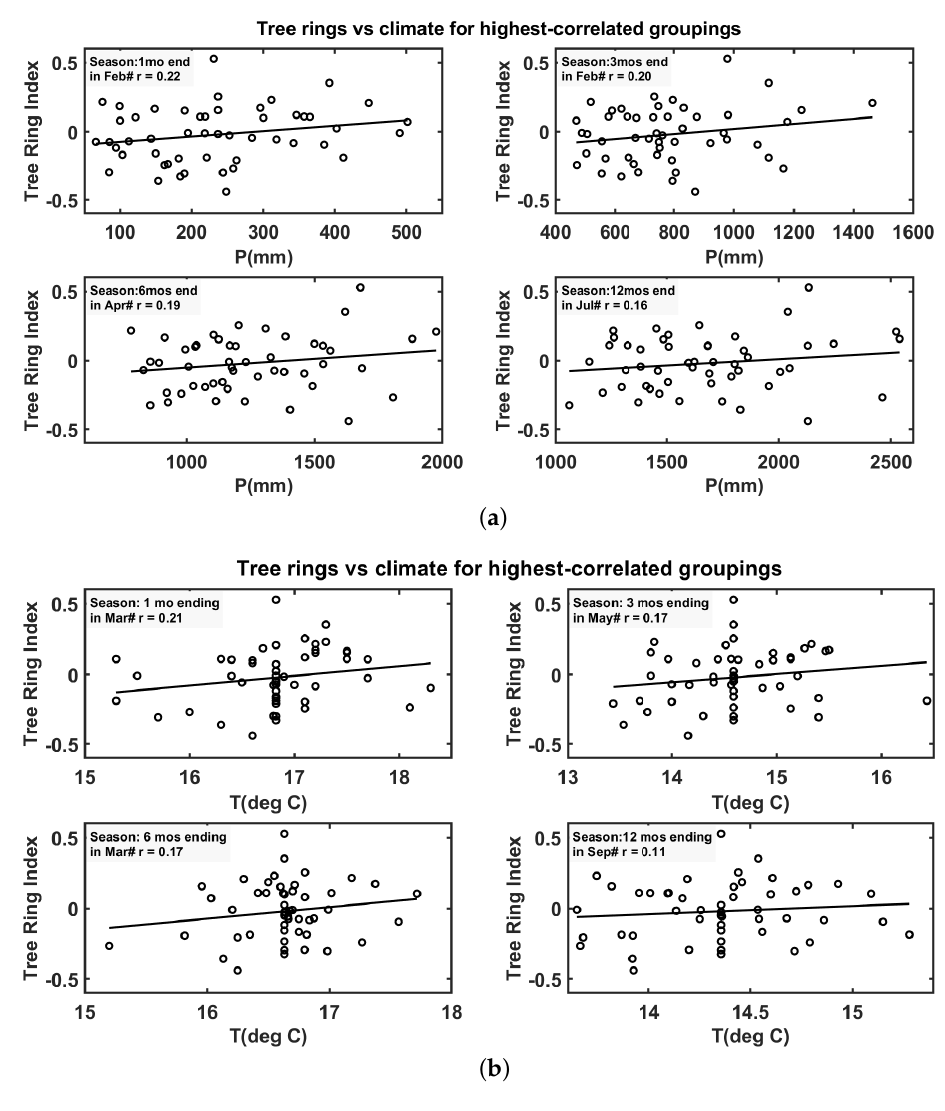
Figure 10. Data distribution between mean chronology and the precipitation ( a ) and the temperature ( b